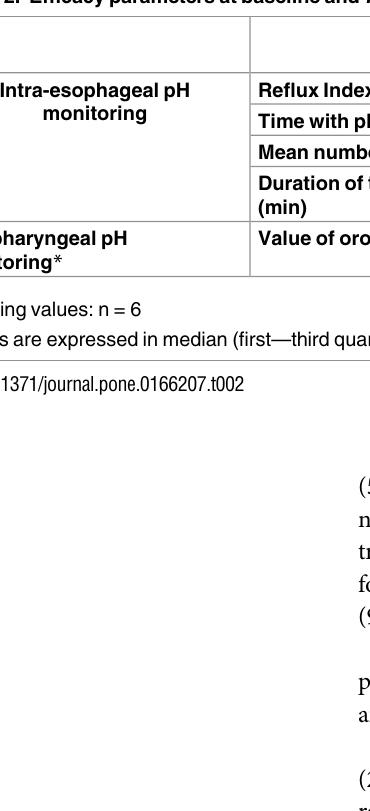
Table 3. Sequential estimation of posterior probabilities of success after the inclusion of each group of three patients in the group of neonates born at less than 32 weeks of gestational age.